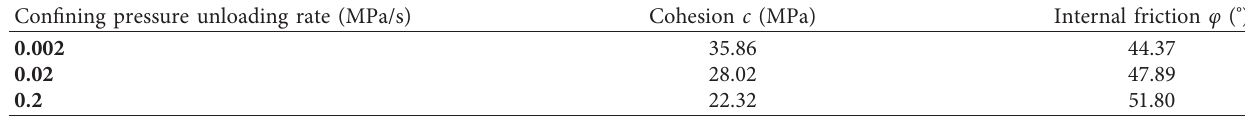
Table 3: Strength parameters of granite samples under different unloading confining pressure